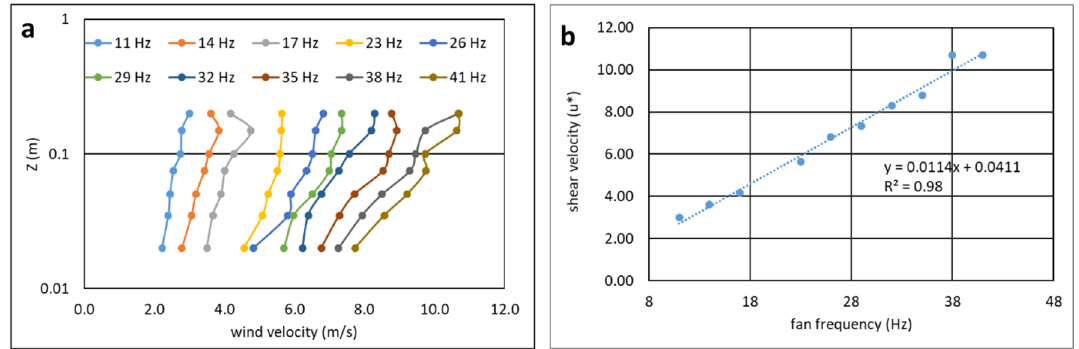
Figure 2. ( a ) Wind velocity (m/s) measured at different heights above the tunnel bed (z) under different fan frequencies (Hz) ( b ) Correlation between the fan frequencies applied in the wind tunnel and the calculated shear velocity.